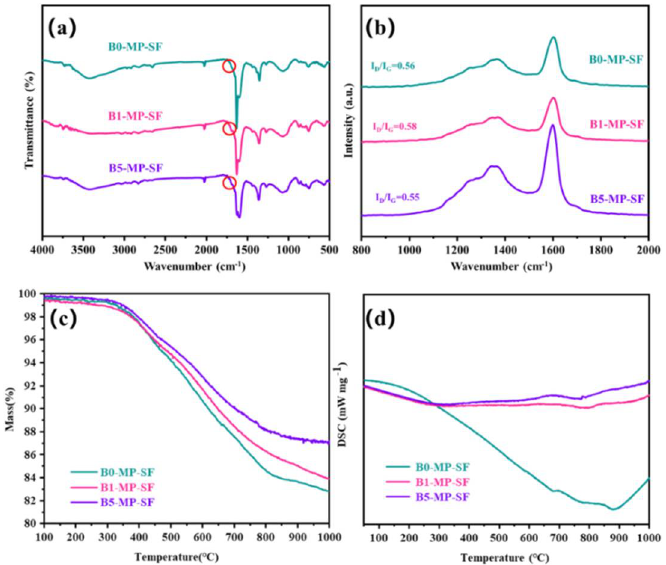
Figure 3. FTIR spectra ( a ), Raman spectra ( b ), and TG−DSC curves in nitrogen mood ( c , d ) of B0−MP−SF, B1−MP−SF and B5−MP−SF.